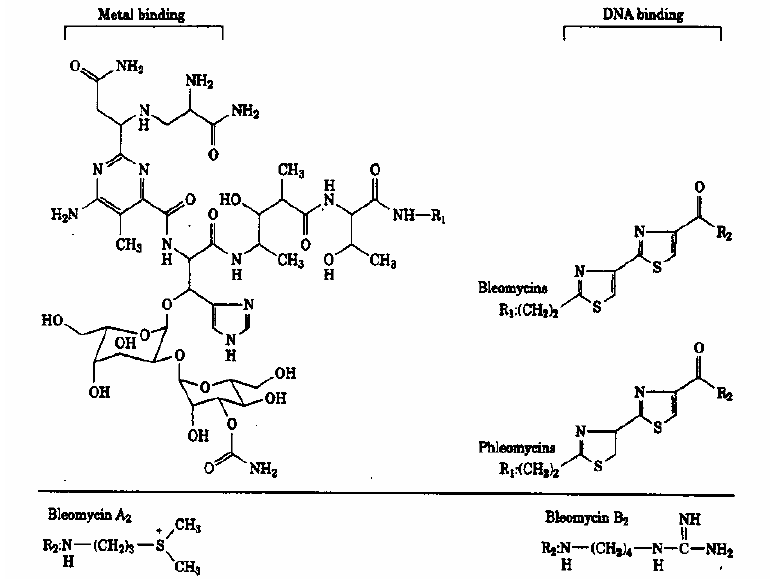
Figure 1. Structures of bleomycins and phleomycins. Figure taken from Moore, 1999.